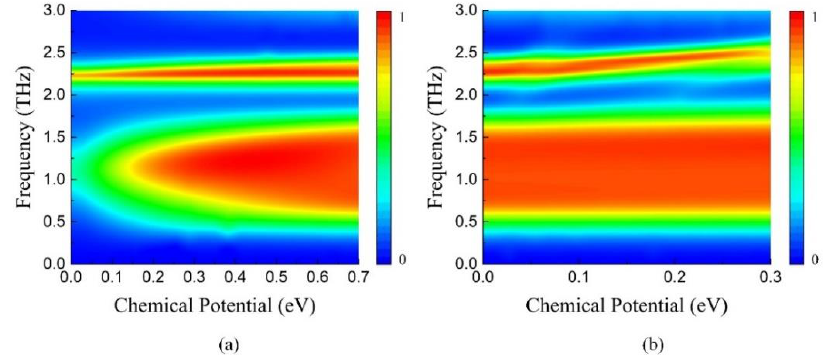
Figure 10. Absorption spectrum of the independently tunable dual-band absorber as a function of frequency and chemical potential ( a ) E F1 : 0–0.7 eV, E F2 = 0 eV ( b ) E F1 = 0.7 eV, E F2 : 0–0.3 eV.